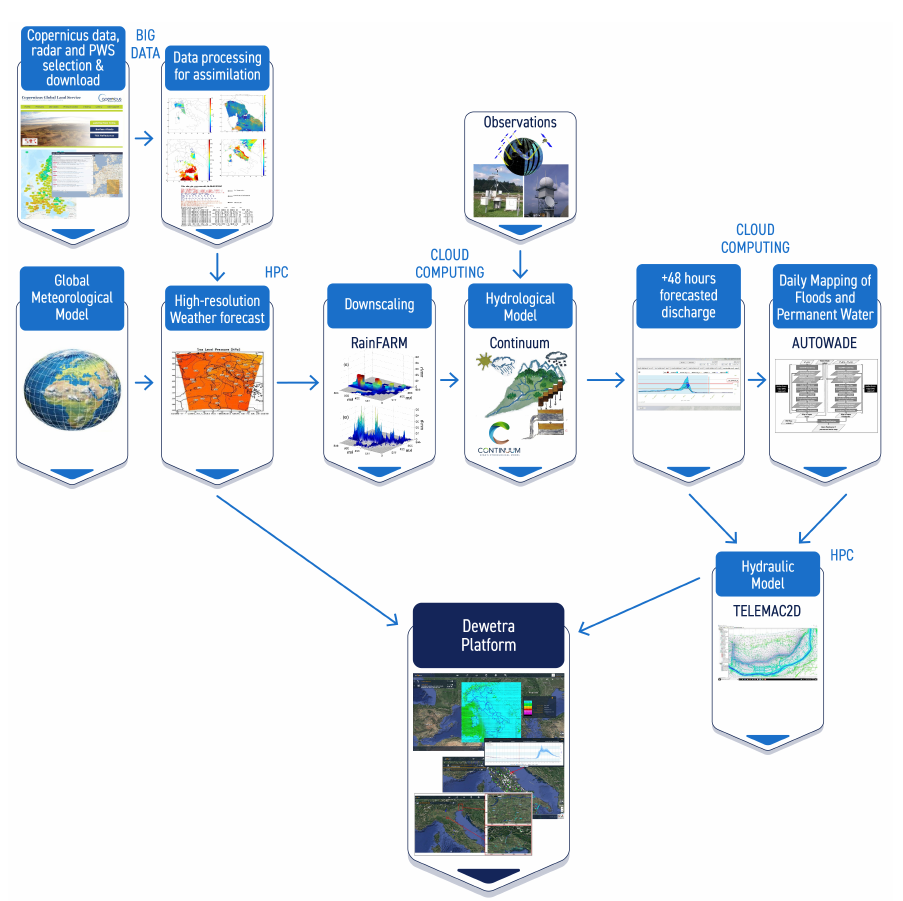
Figure 1. Meteo /Hydro forecasting chain